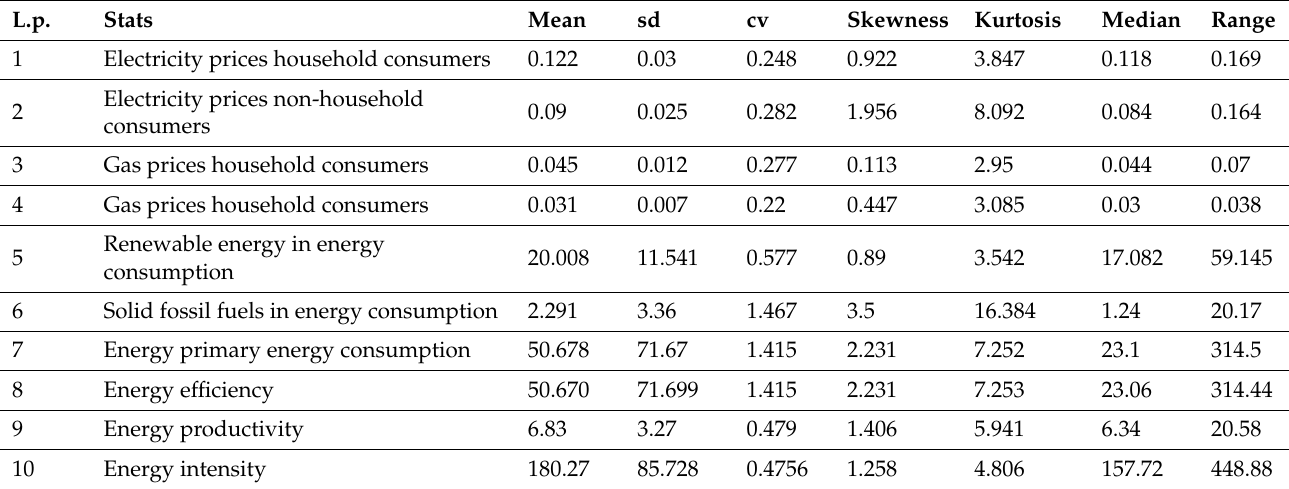
Table 3. Descriptive statistics—dependent variables.